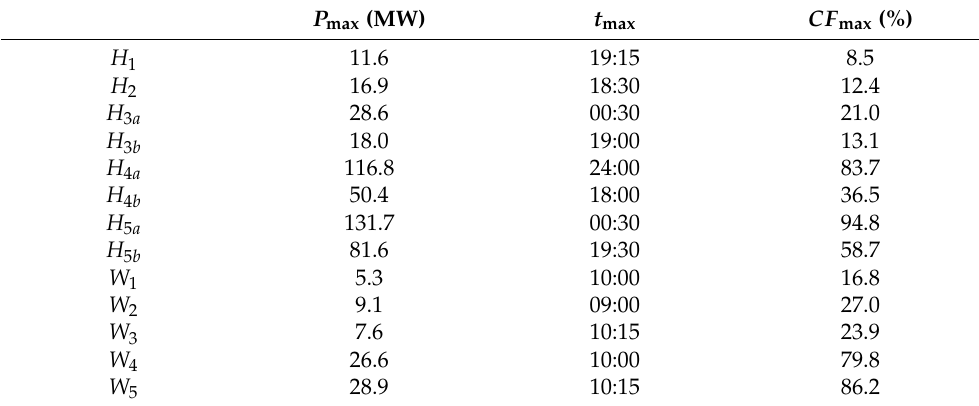
Table 5. Summary of the aggregated EV peak power demand for each charging scenario, decom- posed according to home and workplace contributions. We list its magnitude P max , time t max and coincidence factor CF max